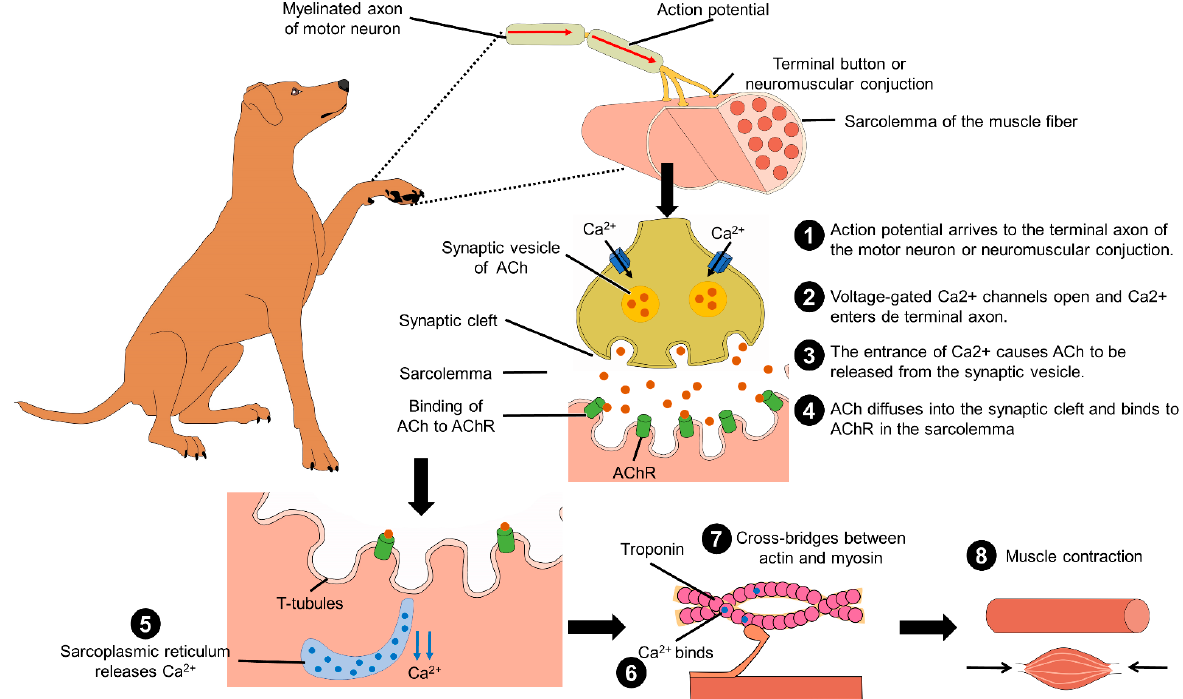
Figure 4. Biochemical process for muscle contraction and movement. In the myelinated axon of motor neurons, the action potential arrives at the neuromuscular conjunction of the sarcolemma. This produces the entrance of Ca 2+ by opening the voltage-gated Ca 2+ channels, and the increment of intracellular Ca 2+ causes ACh to be released from the synaptic vesicle to the synaptic cleft. In the sarcolemma of the muscle, ACh binds to AChR, the action potential travels along the T-tubules. Later, the sarcoplasmic reticulum releases Ca 2+ that will bind to troponin and produce the cross-bridge between actin and myosin. This interaction leads to muscle shortening and contraction. ACh: acetylcholine; Ca 2+ : calcium.